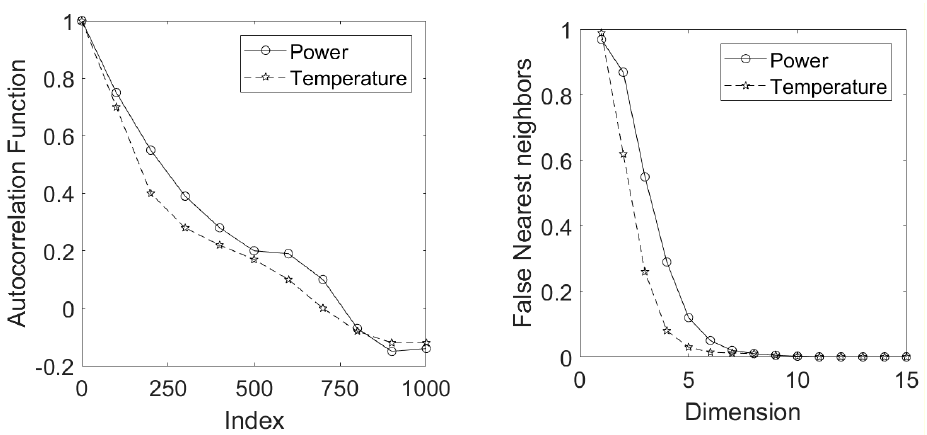
Figure 17. The autocorrelation function (left) and false nearest neighbor (right) plots of power draw (solid lines) and outlet temperature (broken lines) time series.